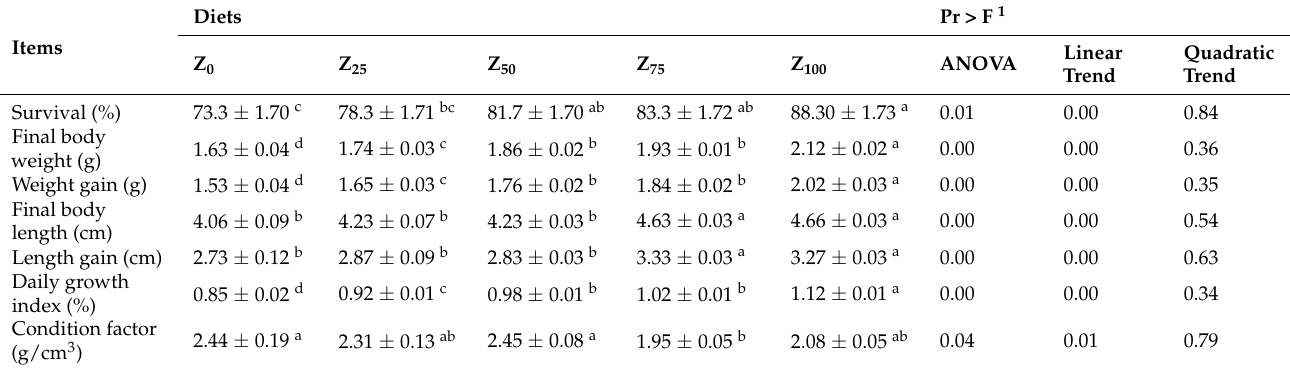
Table 3. Survival rate and growth of grey mullet, Mugil cephalus , fed experimental diets for 60